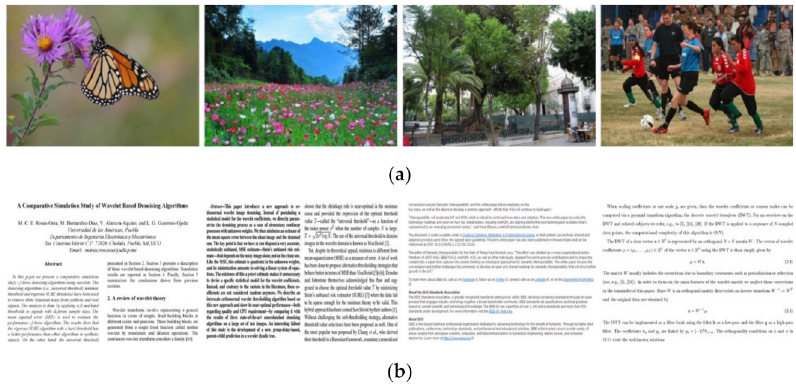
Figure 3. Some examples of the collected pristine images for model learning: ( a ) natural images and ( b ) artificial